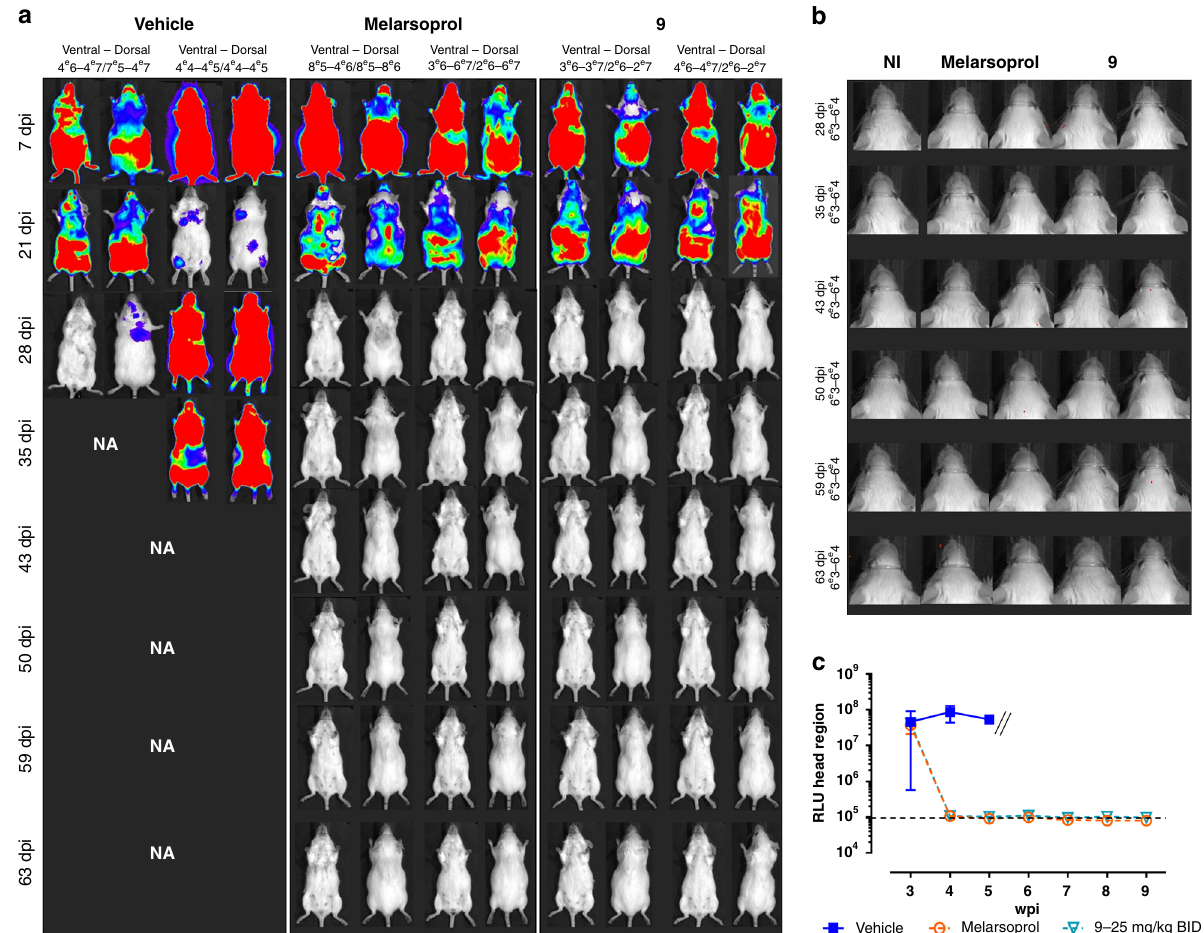
Fig. 3 In vivo evaluation of 9 in a stage 2 mouse model of HAT. a BLI images of stage 2 T. b. brucei -infected mice treated at 21 dpi with vehicle ( n = 2), melarsoprol ( n = 2) or 9 ( n = 2). Images were acquired from the dorsal and ventral sides of the animal. Image scales are indicated for each animal. NA = data not available due to animals in the control group succumbing to infection. b BLI images of the head region of melarsoprol and compound 9 -treated mice, with a non-infected animal (NI) as a reference. c BLI (average signal ± SEM) of the head region. // = data not available due to animals in the control group succumbing to infection. Dashed lined represents the background signal in a non-infected animal. Source data are provided as a Source Data fi